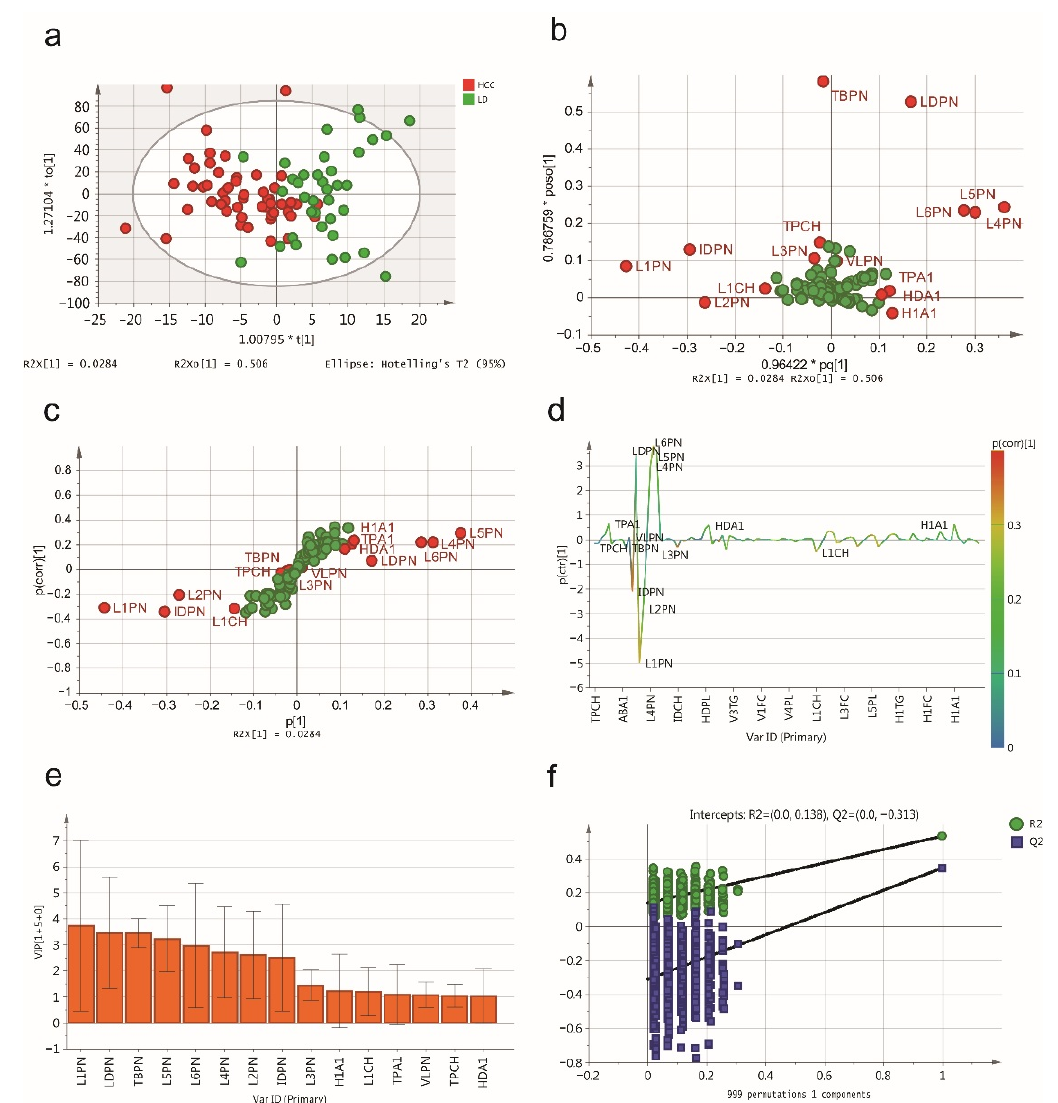
Figure 2. The serum lipidomic profile discriminates between HCC patients and liver disease (LD). ( a ) Score plot was generated by the OPLS-DA model. The horizontal coordinate (1.00795 * t [1]) represents the score value of the main component, and the vertical coordinate (1.27104 * to [1]) represents the score value of the orthogonal component. ( b ) Loading plot was generated by the OPLS-DA model. The horizontal coordinate (0.96422 * pq [1]) represents the predicted principal component, and the vertical coordinate (0.786795 * poso [1]) represents the orthogonal principal components. The corresponding ( c ) S-plot and ( d ) S-line plot for the model displaying the discriminant variables and the associated predictive loadings. The red circles indicate selected lipoprotein subfractions with VIP scores >1.0, and other variables with no difference are referred to as green circles in ( b , c ). ( e ) The selected lipoprotein subfractions with VIP scores >1.0. ( f ) Permutation test (999 times) of the OPLS-DA model.